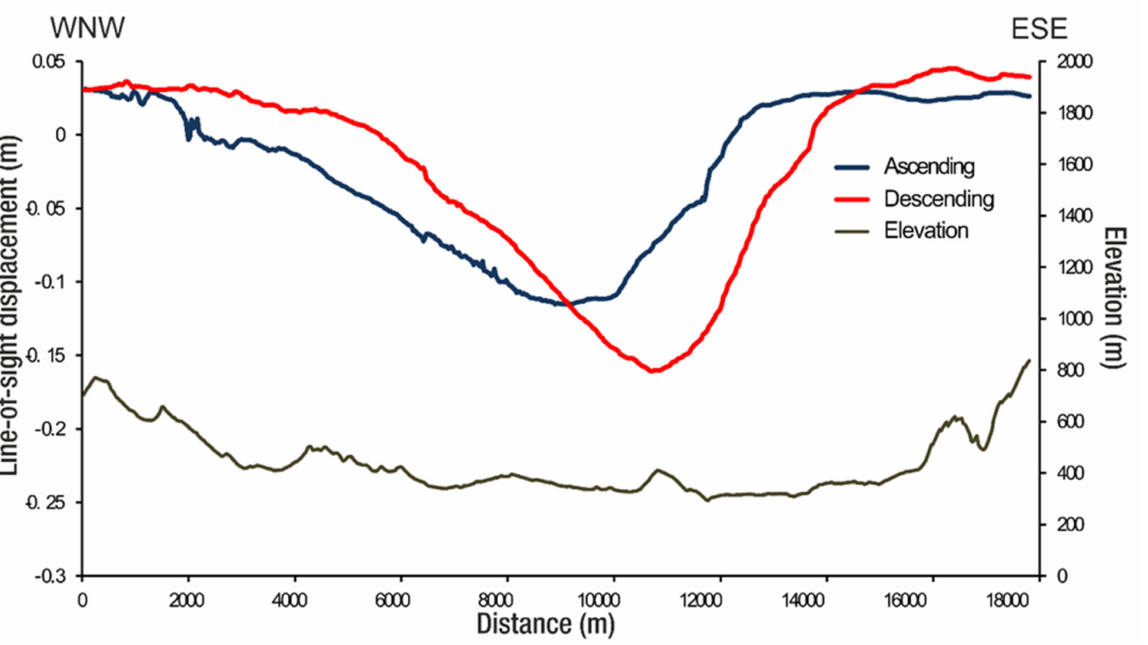
Figure 13. Cross-section (heading N110 ◦ E) showing ground deformation from LOS unwrapped data of the Arkalochori earthquake of 27 September 2021. Topography is shown with grey line. See Figure 1 for profile